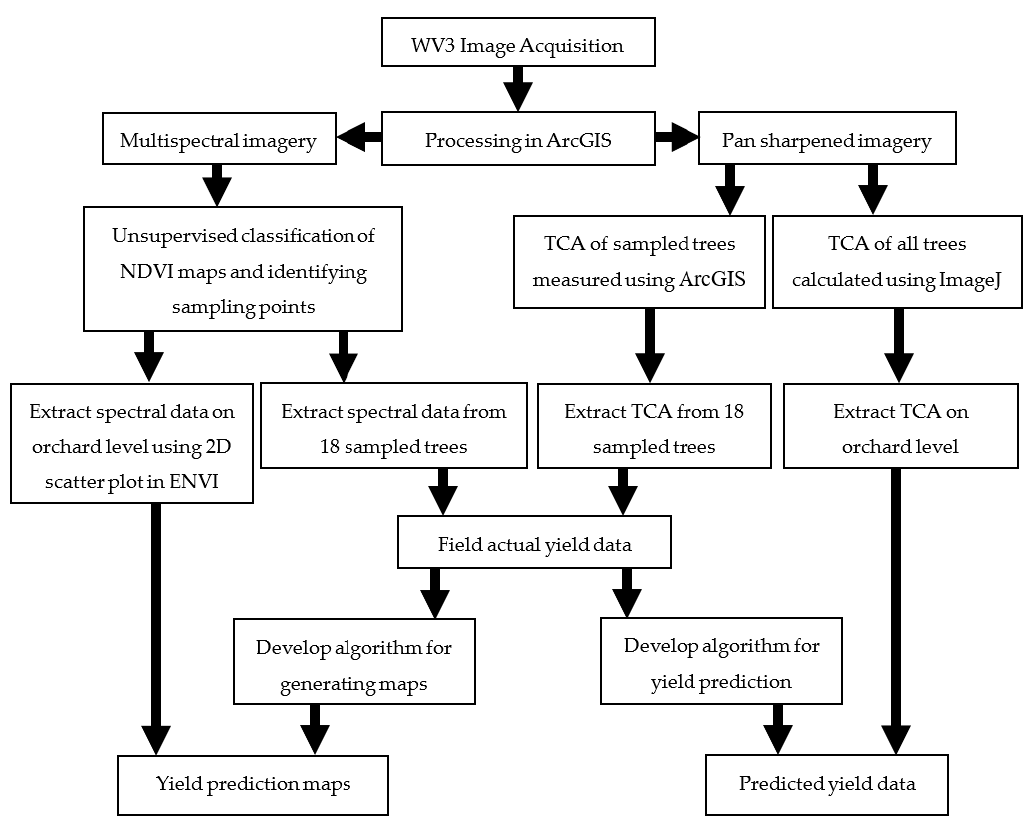
Figure 4. The flowchart of developing algorithm and derivation of orchard level yield maps